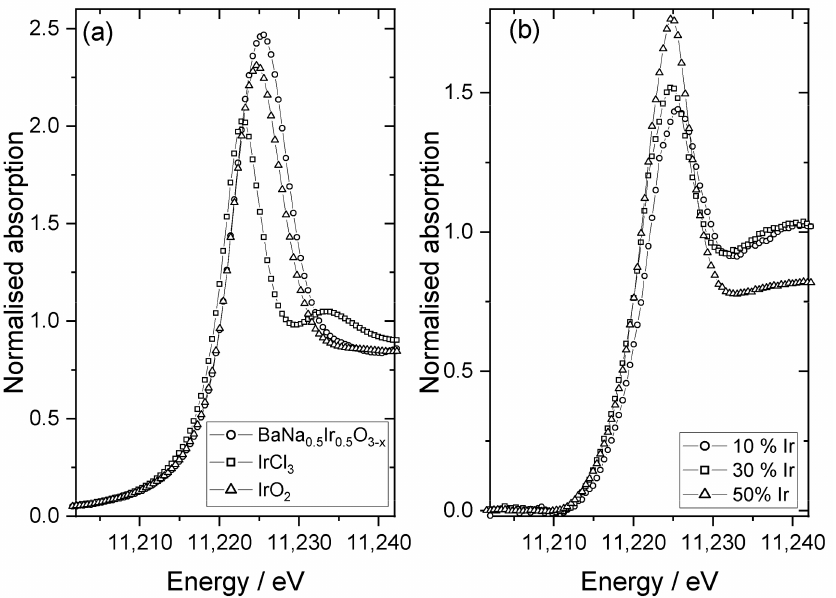
Figure 5. Ir L III -edge XANES spectra: ( a ) reference materials for oxidation state calibration and